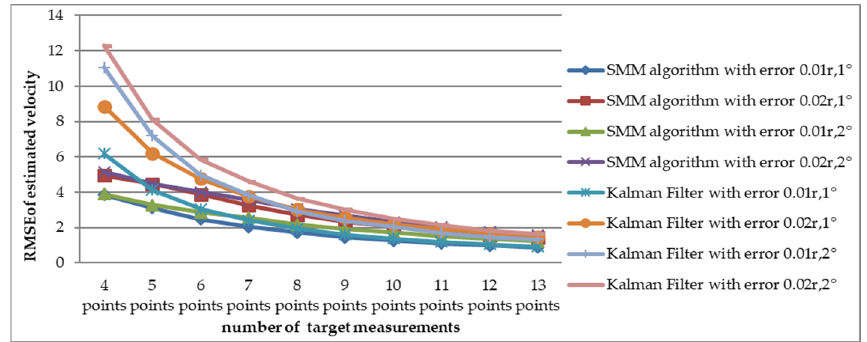
Figure 7. Comparison of estimated velocity RMSE between SMM algorithm and adaptive Kalman filter versus different detection error (Scenario 1).